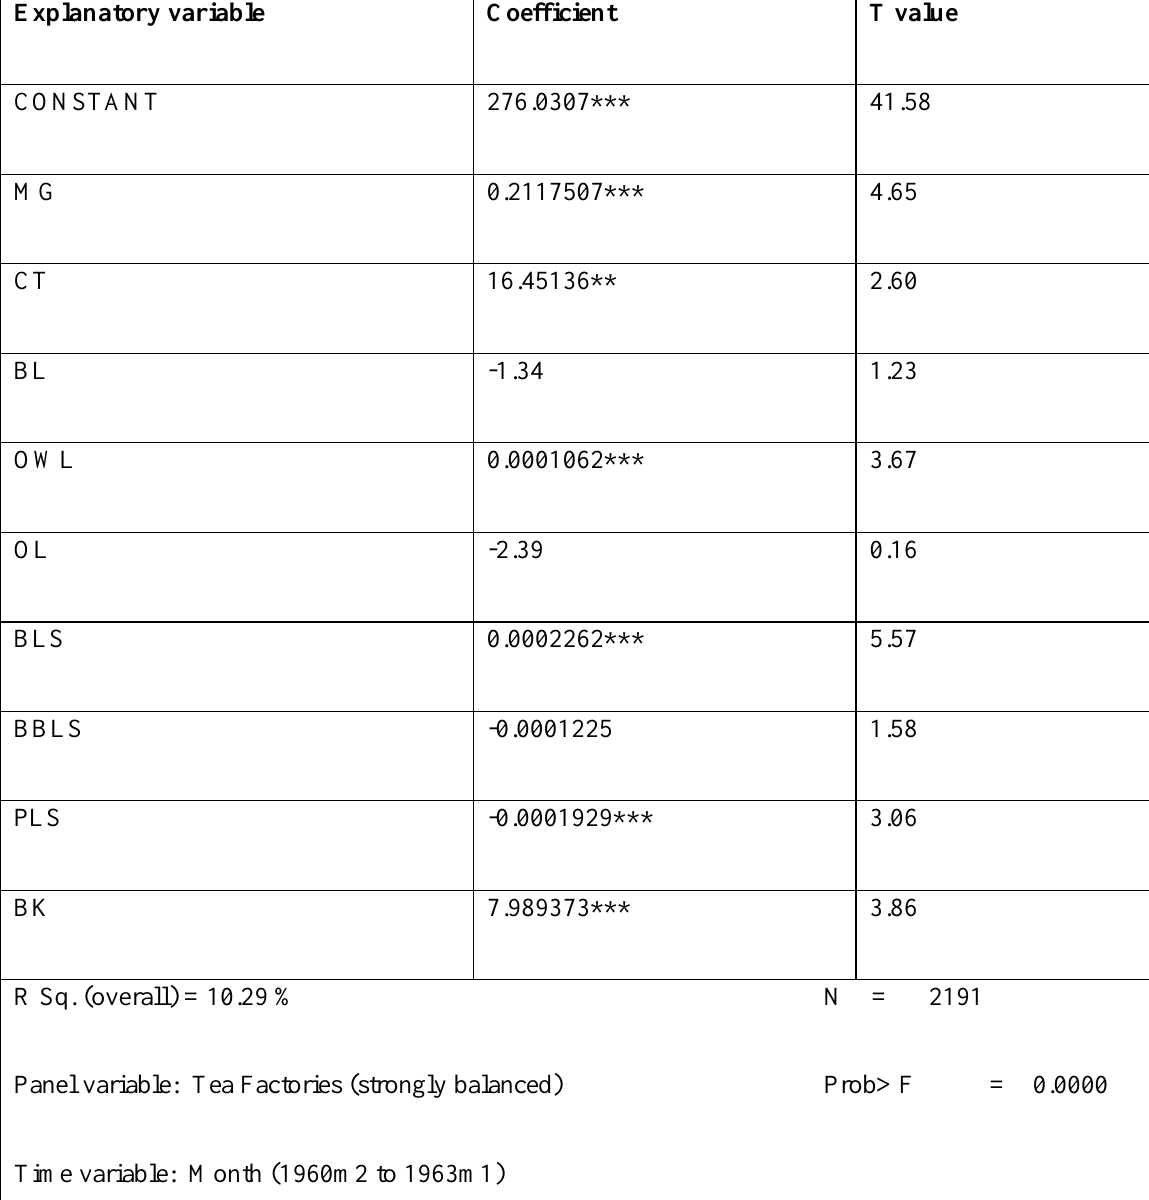
Table 2: Results of Panel Data Regression